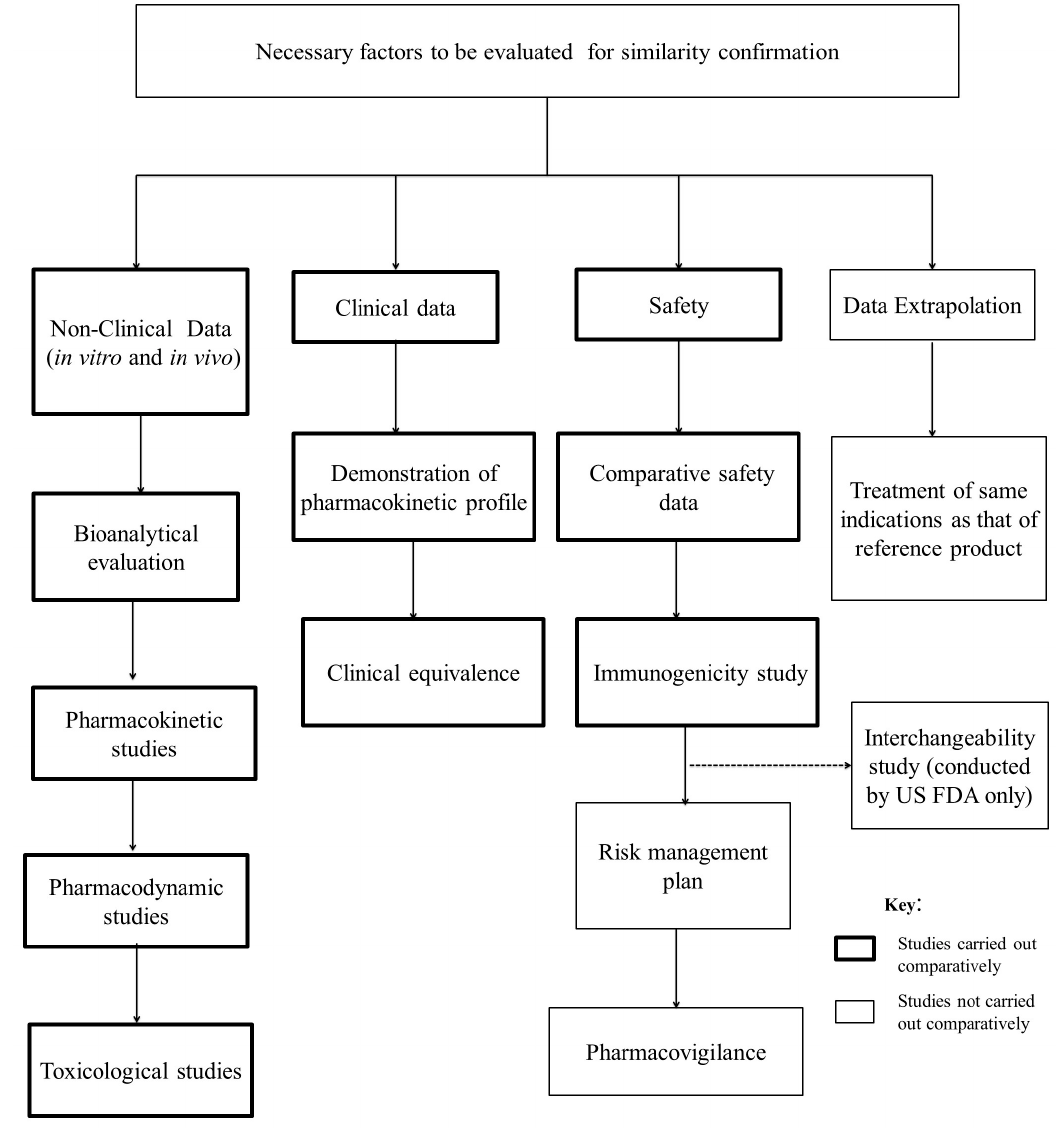
Figure 3. Factors to be evaluated for confirmation of similarity.